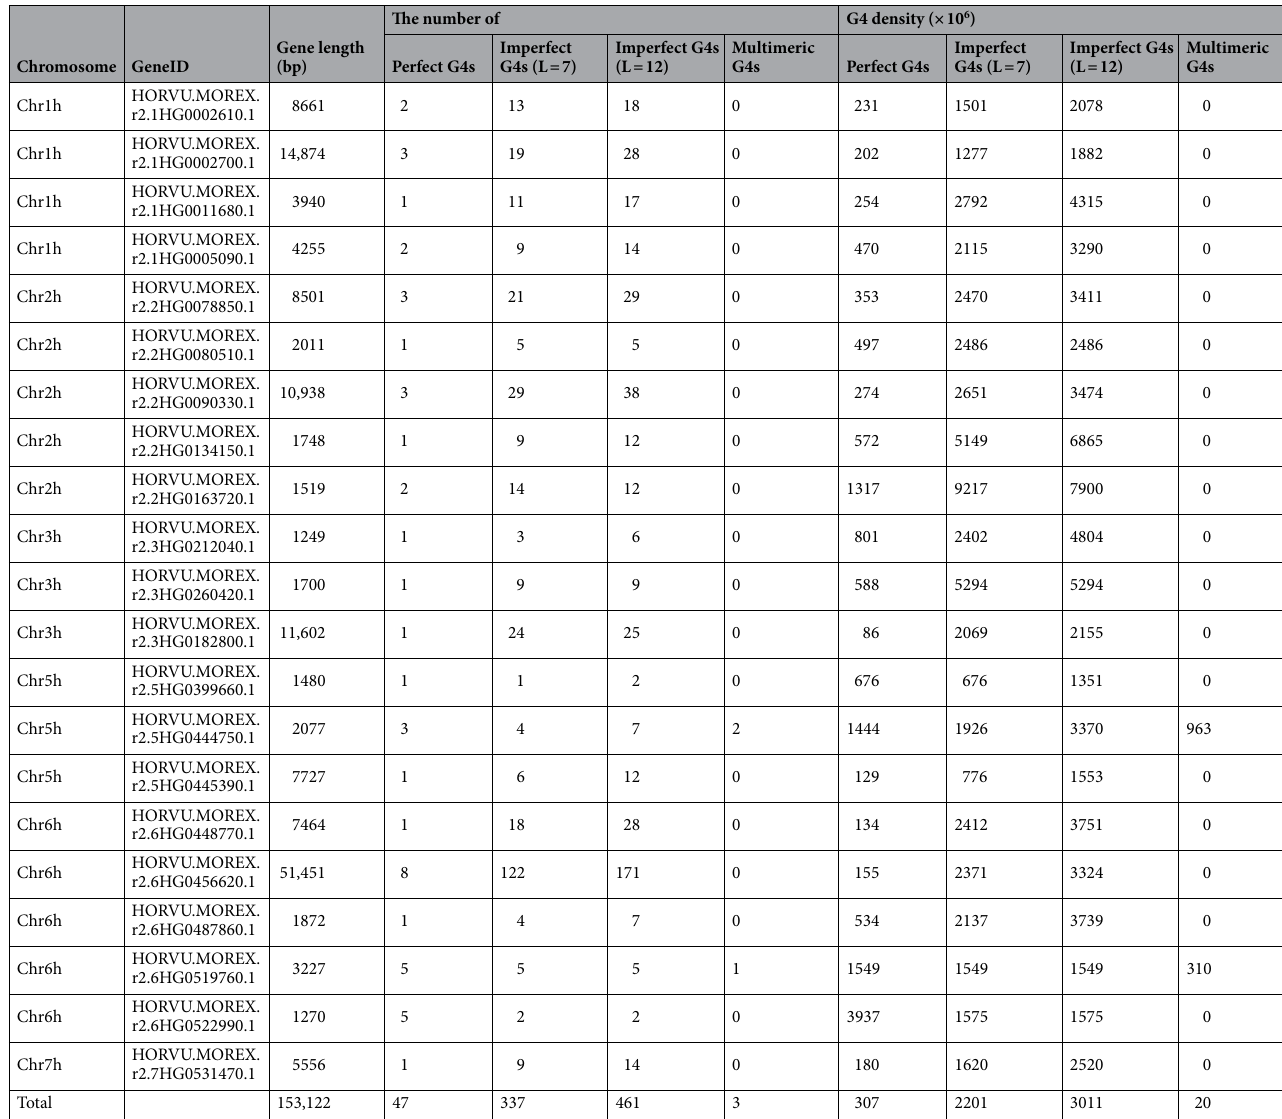
Table 1. Composition of the four different G4 motifs within the NBS genes. 21 NBS genes that lack known NBS motifs but overlap with a perfect G4 motif are represented. Gene length accounts for the length of the gene and the 500 bp of both upstream and downstream of the